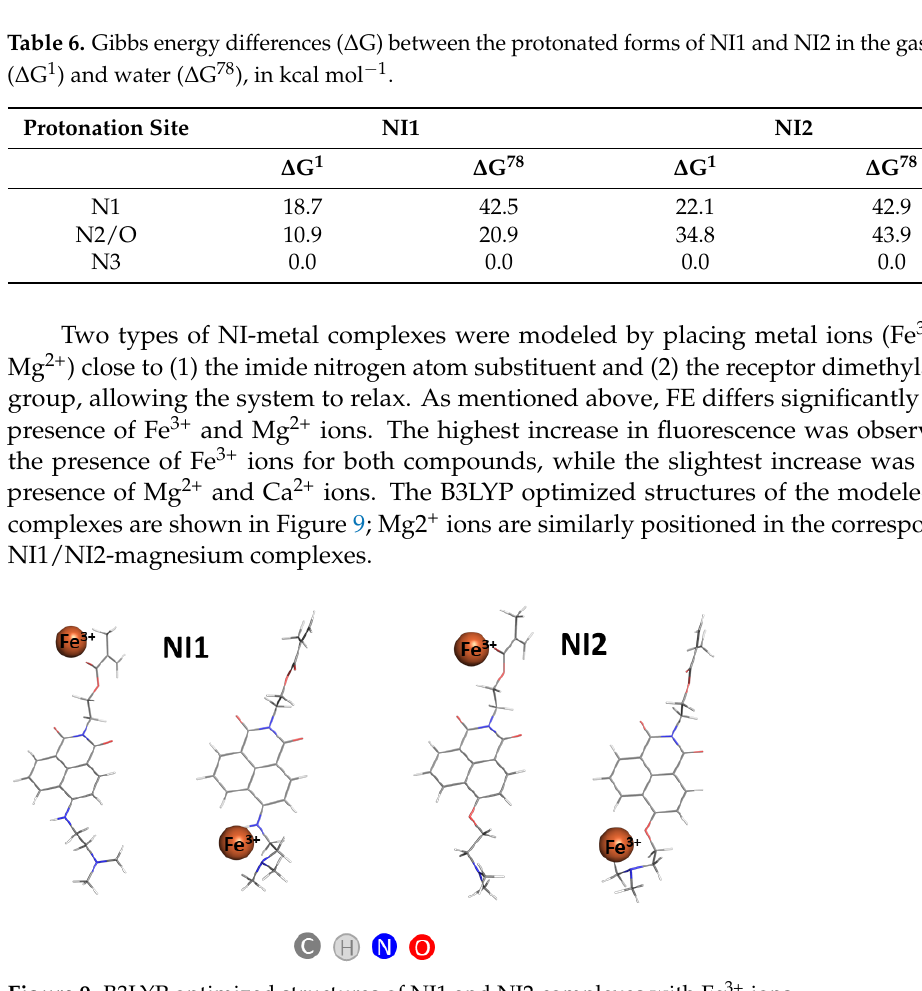
(Table 7): − 107.7 kcal mol − 1 vs. − 98.4 kcal mol − 1 for NI1 and − 102.7 kcal mol − 1 vs. −1 07.7 kcal mol −1 vs. −9 8.4 kcal mol −1 for NI1 and −1 02.7 kcal mol −1 vs. −9 3.4 kcal mol −1 ,